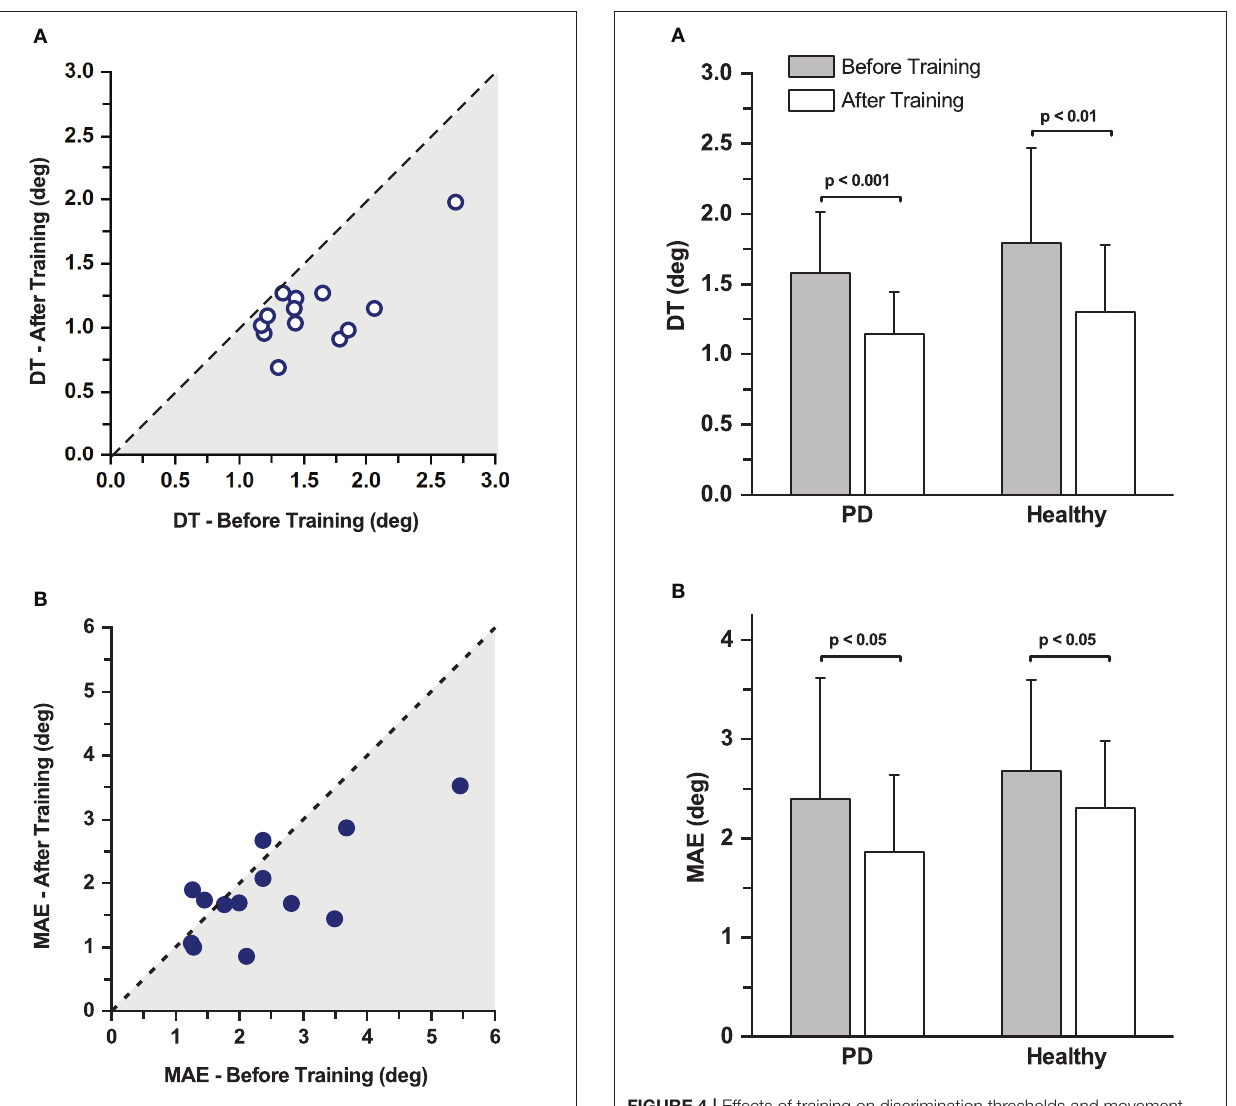
FIGURE 3 | Effects of training on discrimination thresholds and movement accuracy in the PD gorup. (A) Proprioceptive discrimination thresholds (DT) before and after training. The dashed line indicates the line of equality representing a no change as a function of training. Shaded area marks the region of lower thresholds indicating improvements after training. (B) Movement Accuracy Error (MAE) before and after training. The dashed line indicates the line of equality representing a no change as a function of training. Shaded area marks the region of lower MAE indicating improvements after training. Note that 10/13 participants improved after training.